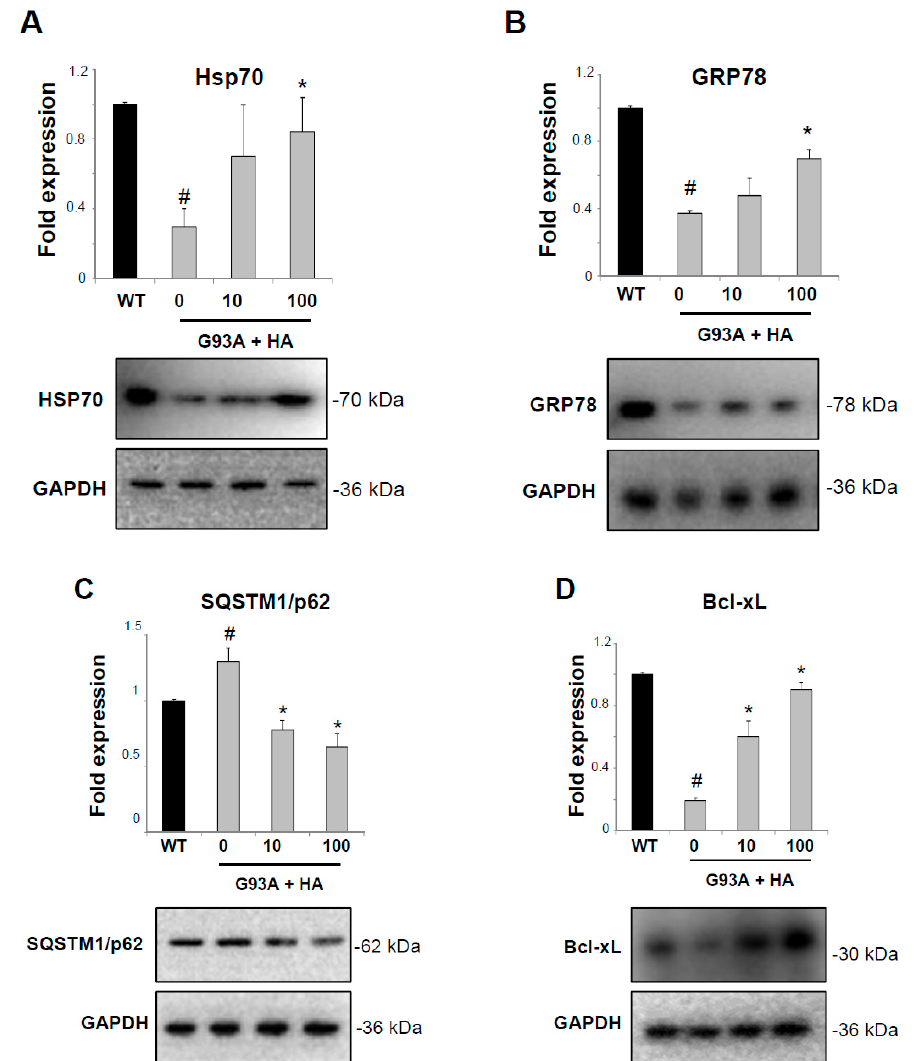
Figure 1. Histamine induces the heat shock response in SOD1-G93A microglia. Representative western blots and quantification of Hsp70 ( A ), GRP78 ( B ), SQSTM1 / p62 ( C ) and Bcl-xL ( D ) in wild-type (WT) and SOD1-G93A microglia treated with histamine (10–100 µ M) for 6 h. GAPDH was used for protein normalization. HA = histamine. Data represent mean ± S.E.M. ( n = 3 independent experiments). Statistical significance was calculated by ANOVA, as referred to WT cells, # p < 0.05 or to SOD1-G93A untreated cells, * p < 0.05.